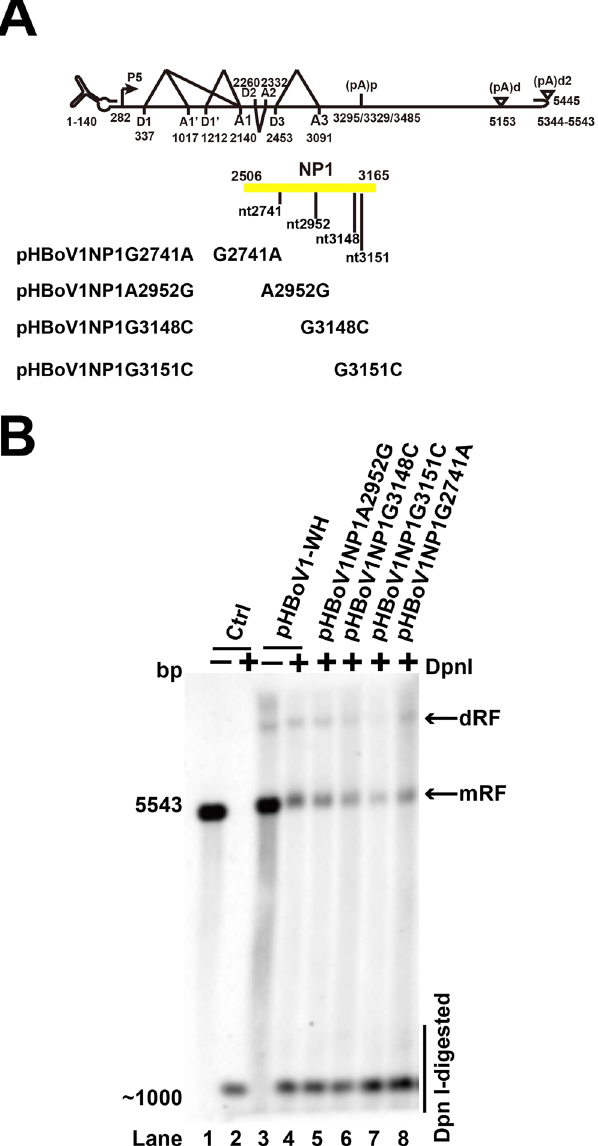
Figure 4. NP1 mutations did not affect HBoV1 genomic DNA replication. ( A ) NP1 ORF and mutations. Diagram of NP1 ORF and mutations from either clinical samples or reported cases are shown. ( B ) Southern blot analysis. Plasmids in panel A were transfected into HEK293T cells. DNA samples were harvested and digested with Dpn I. Southern blots were performed, and the signal was detected by ChemiDoc TM MP imaging